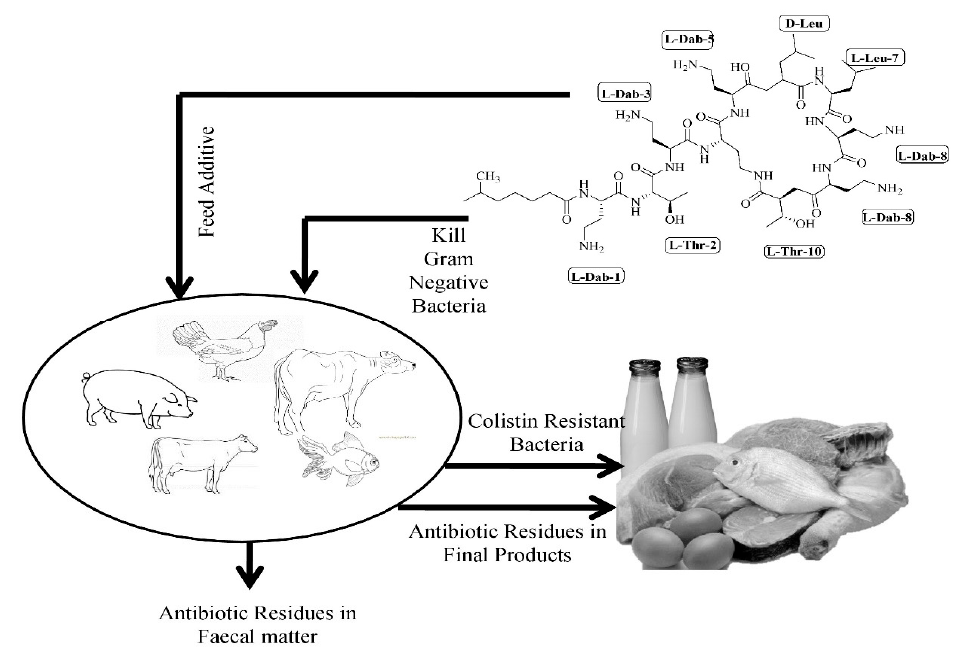
Figure 2. Graphical illustration of the spread of antibiotic-resistant bacteria as well as accumulation of colistin in animal products.